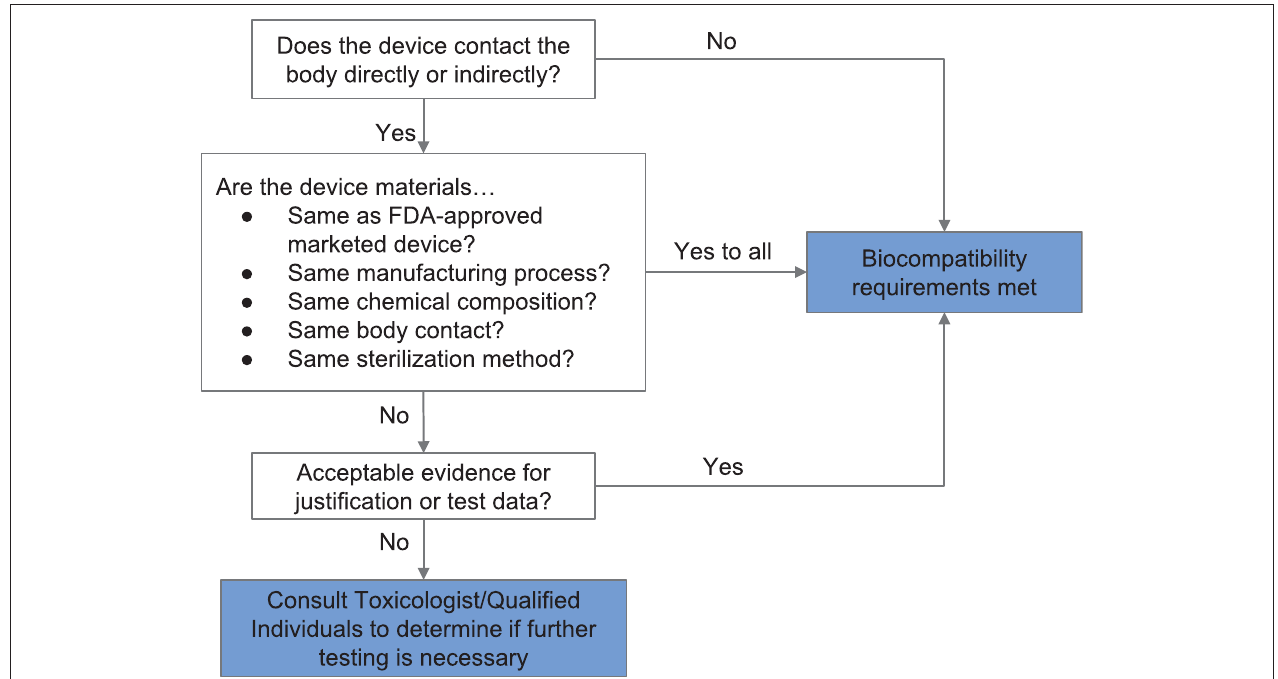
FIGURE 2 | Systematic approach to a biological evaluation of medical devices as part of a risk management process. The process is simplified from FDA Guidance document for ISO 10993-1 (